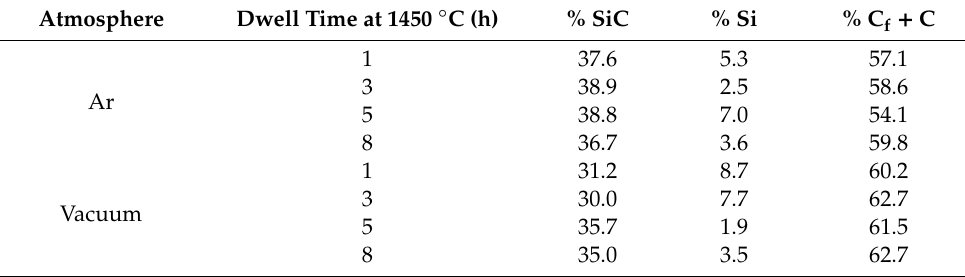
Table 4. Phase quantification of infiltrated C f /SiC composite materials.